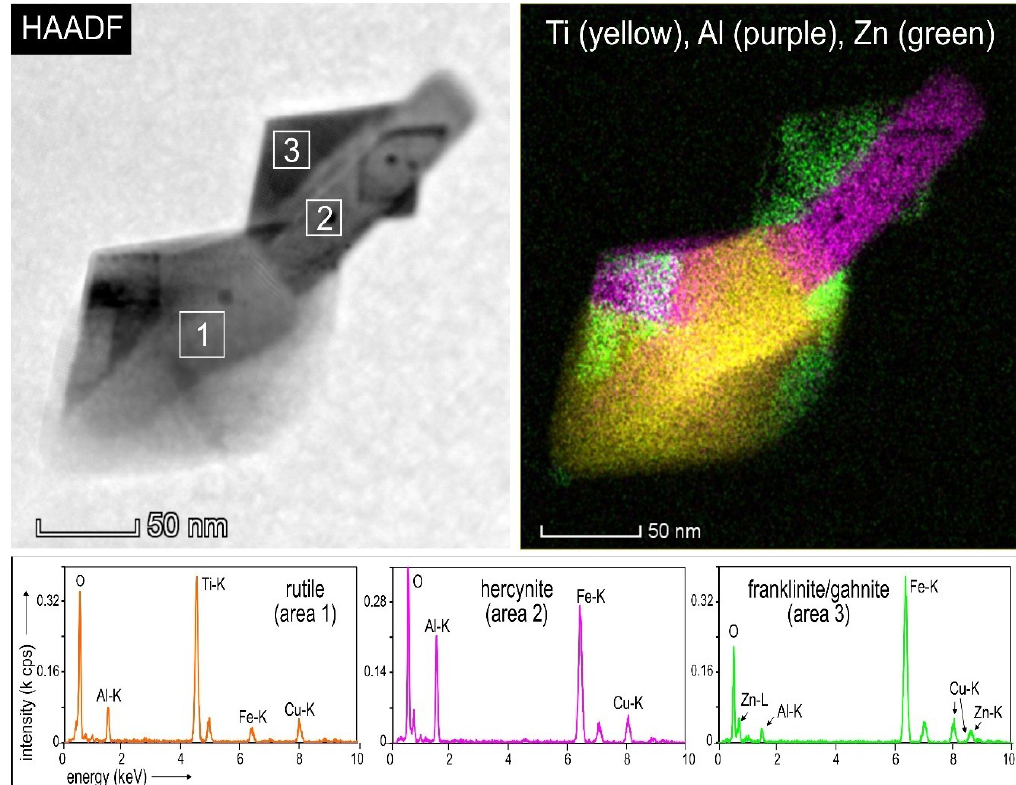
Figure 10. HAADF STEM (left side) image and overlap between Ti, Al and Zn STEM-EDS maps showing a multi-component inclusion in the magmatic domain of magnetite from foil #6. Spectra for the inclusions collected from areas numbered 1–3 on the HAADF STEM image are shown underneath. The Cu signal is from the TEM grid.